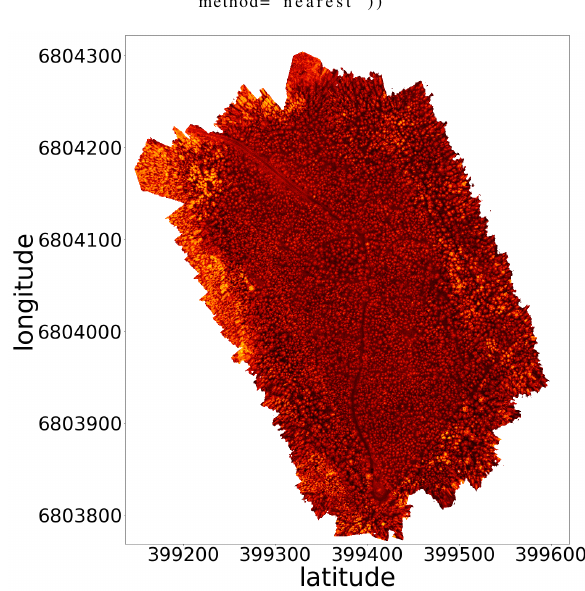
Figure 5. Here we produce a very simple Holoviews visualisation by telling Holoviews Image to use the xarray data we provide it. This is an image of a Finnish forest.